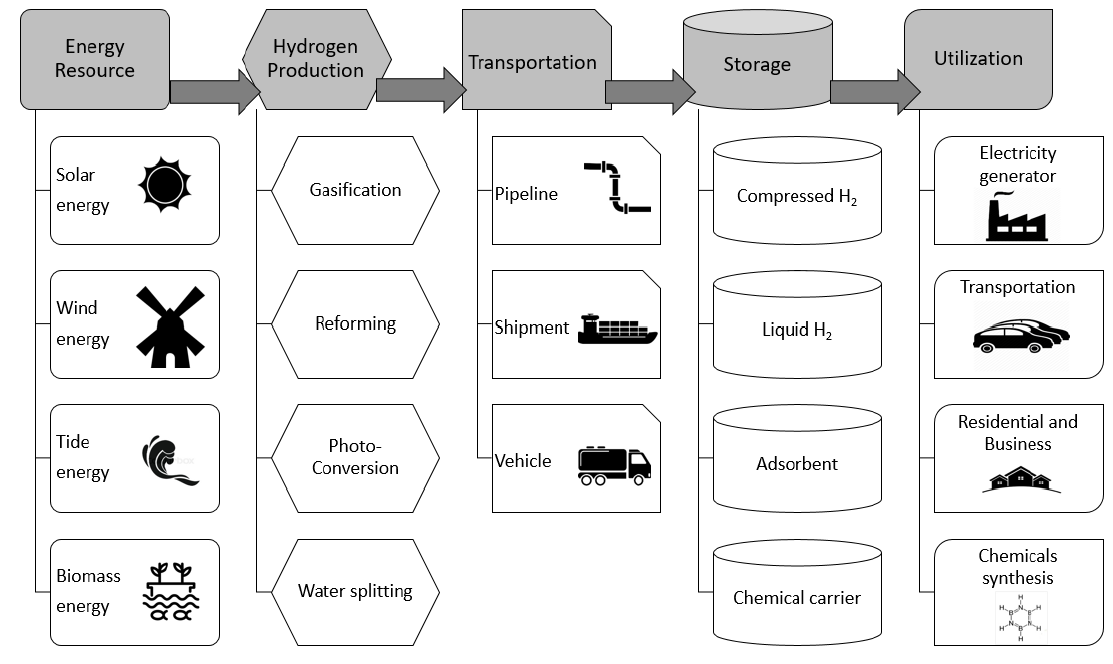
Figure 1. Hydrogen energy system.